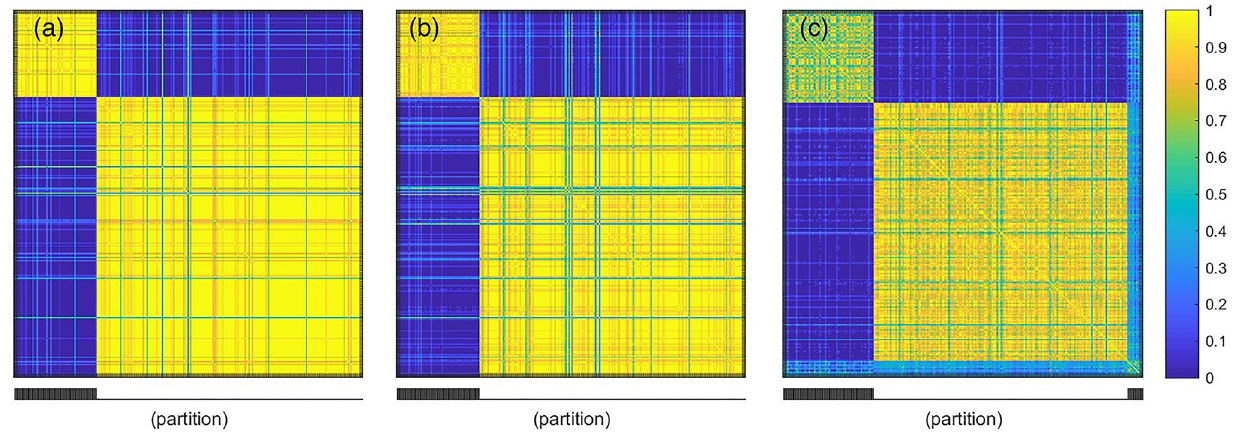
Fig 1. Similarity matrix for the simulation study: (a) the true direction of dependence is considered, (b) no directional dependence is considered, (c) the direction of dependence is reversed. The colormaps show the posterior probability of samples i and j to belong to the same cluster.